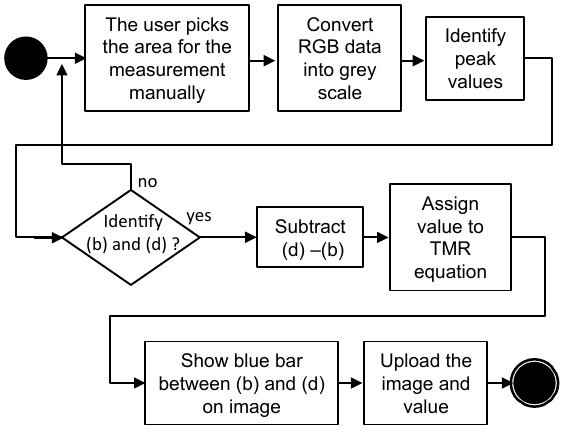
Figure 4. The flow chart of the semi-automatic measurement